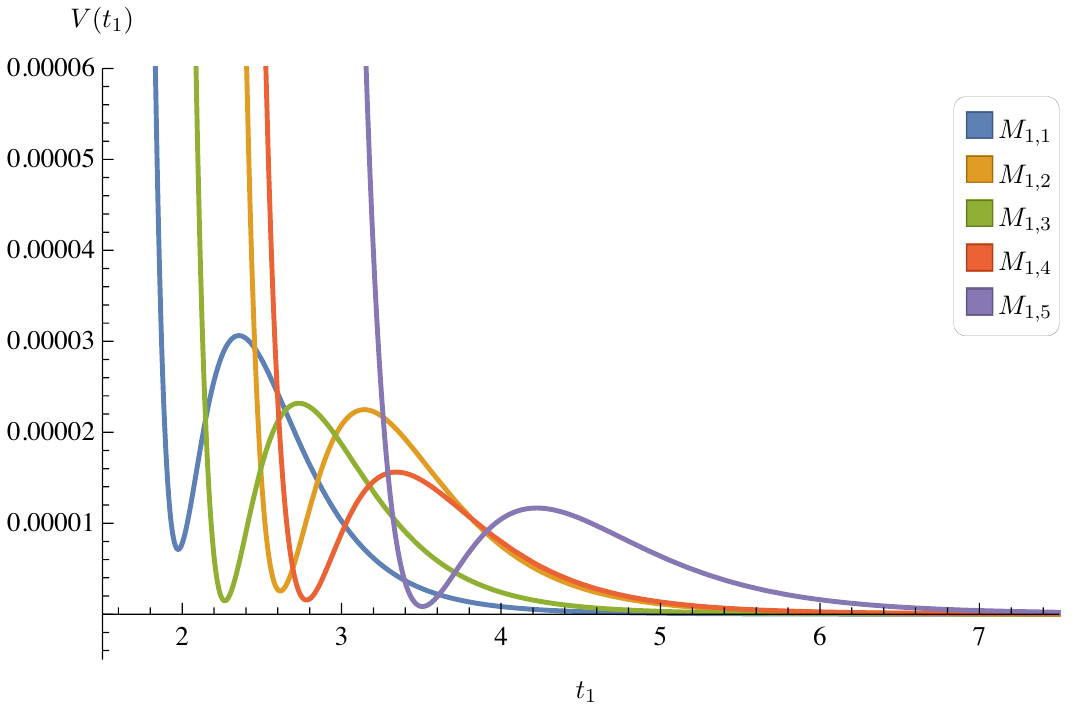
Figure 1 . KKLT scalar potentials V ( t 1 ) with α 0 -uplift for all 5 models in table 5. The corresponding details about the moduli VEVs and V at the minimum are given in table 0